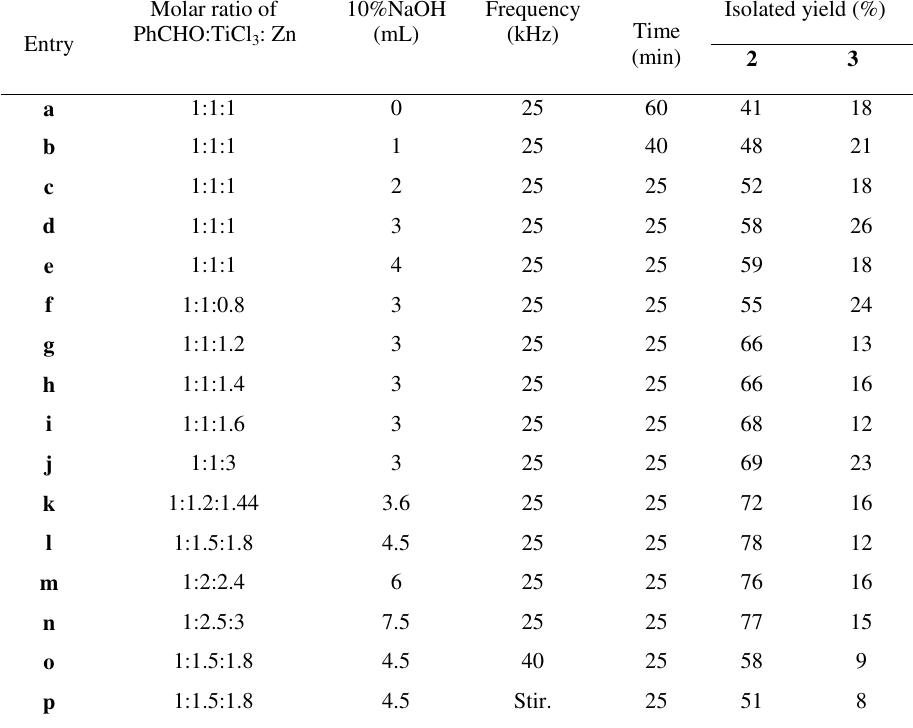
Table 1 Effects of the reaction condition on pinacolization of benzaldehyde under u.s